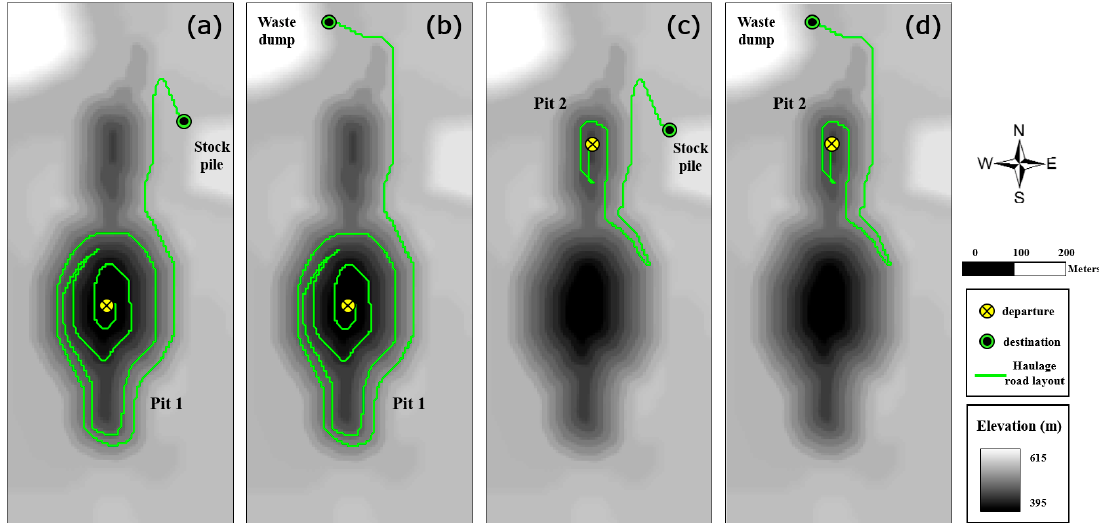
Figure 13. Haul road layout in the Pit 1 and Pit 2 areas analyzed by LCPA. The paths connect the loading point in Pit 1 with ( a ) the stockpile and ( b ) the waste dump and the loading point in Pit 2 with ( c ) the stockpile and ( d ) the waste